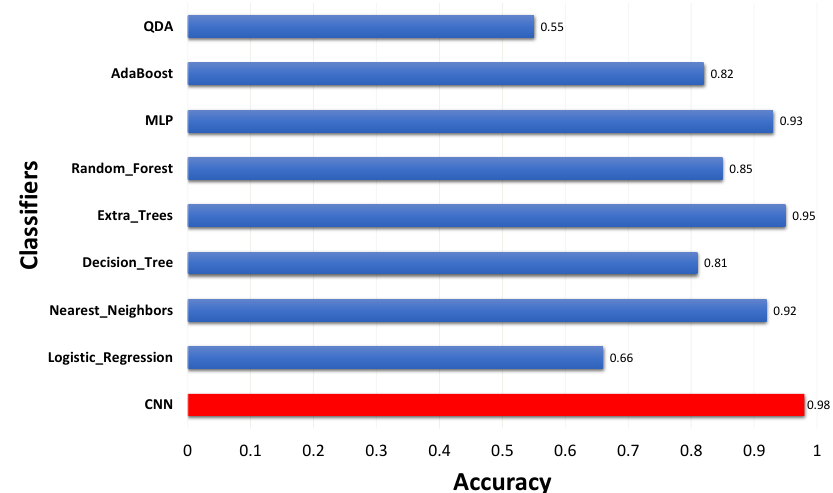
Figure 15. Classifiers’ accuracy